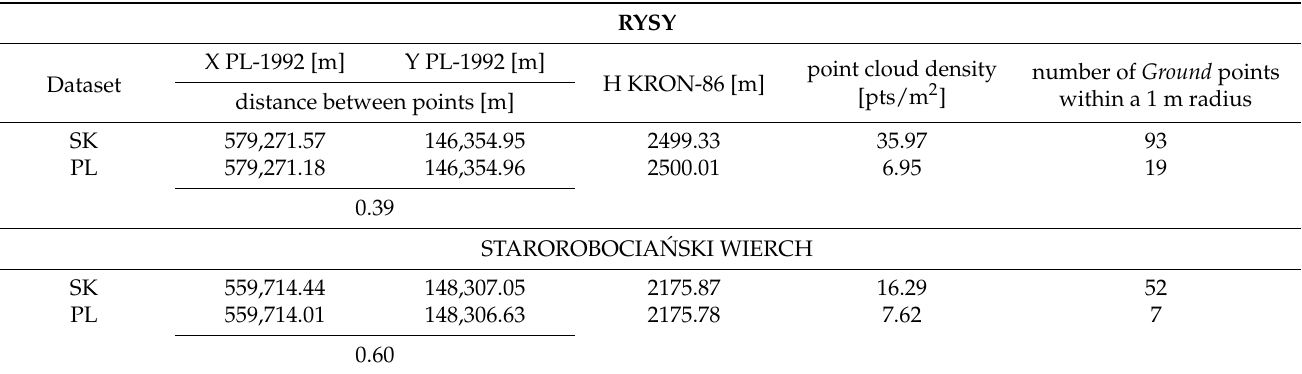
Table 6. Results of numerical comparison of Slovak and Polish ALS datasets.